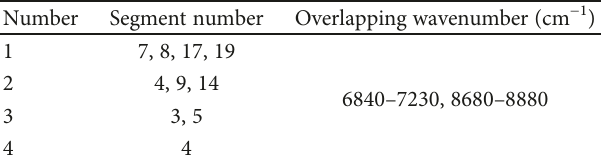
Table 1: Extraction of feature wave bands by